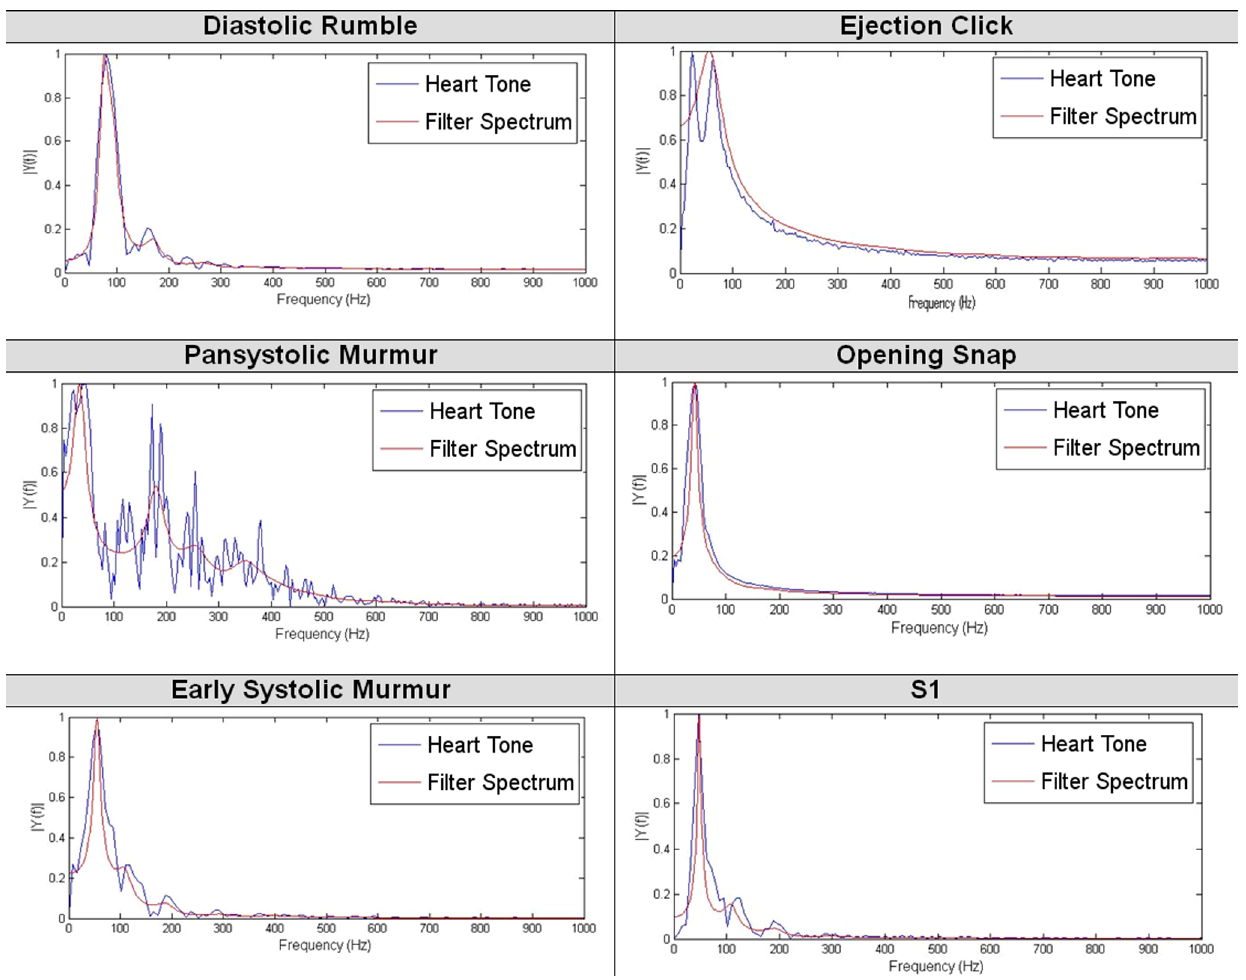
Figure 5. Spectrum comparison of selected heart sounds and LPC filters. Presented curves demonstrate the effectiveness of the modified LPC algorithm in estimating different heart sounds.